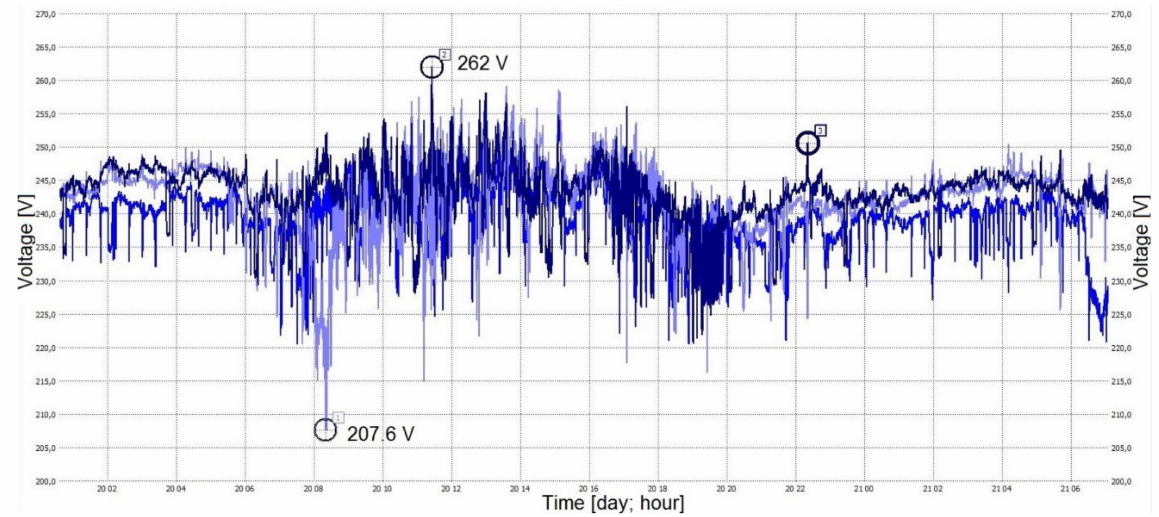
Figure 5. Voltage variations V C in node 114 (period: 20 May 2021, hour 2:00 a.m. − 21 May 2021, hour 4:00